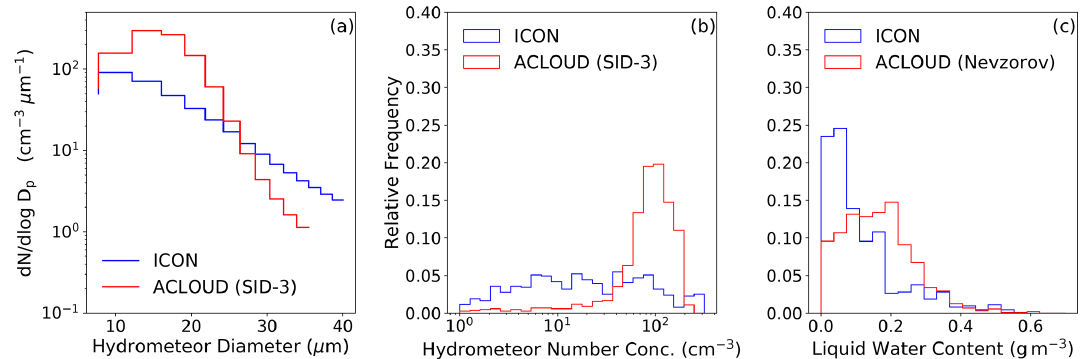
Figure 6. Spatiotemporal average particle number size distribution (a) and relative frequency of total particle number in the diameter range from 5 to 40µm (b) , as well as liquid water content (c) . All data are averaged over the flights from 2 to 5 June over sea-ice-covered region. Filtering for sea-ice-covered ACLOUD flight sections is done using simulated albedo from